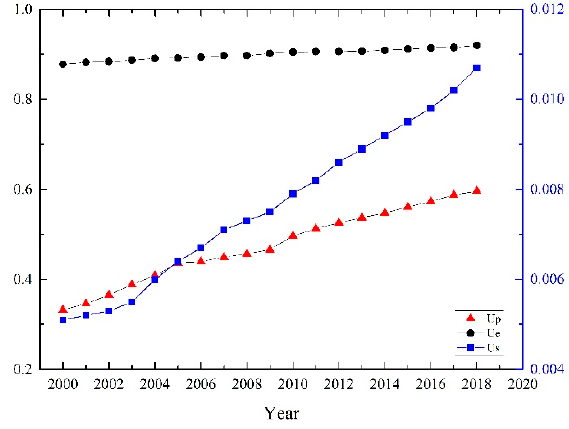
Figure 2. Changes of urbanization development level in China from 2000 to 2018.